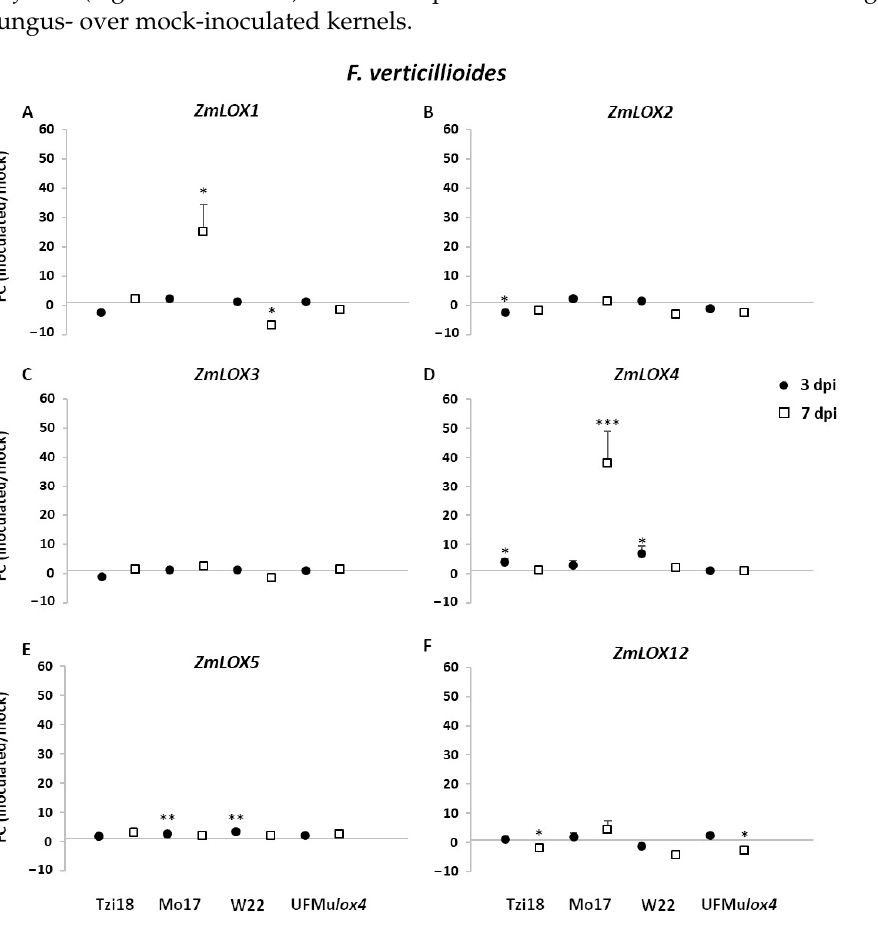
Figure 4. RT-qPCR analysis of maize 9-LOX genes upon F. verticillioides inoculation. Fold change (FC) of expression between inoculated and mock kernels of Tzi18, Mo17, W22, and UFMu lox4 lines at 3 (circle) and 7 (square) dpi with F. verticillioides . ( A ) ZmLOX1 , ( B ) ZmLOX2 , ( C ) ZmLOX3 , ( D ) ZmLOX4 , ( E ) ZmLOX5, and ( F ) ZmLOX12 . Vertical bars indicate the standard error. Asterisk denotes significant upregulation/downregulation with 2-fold or higher FC using Welch’s t -test (* p ≤ 0.05; ** p ≤ 0.01; *** p ≤ 0.001).